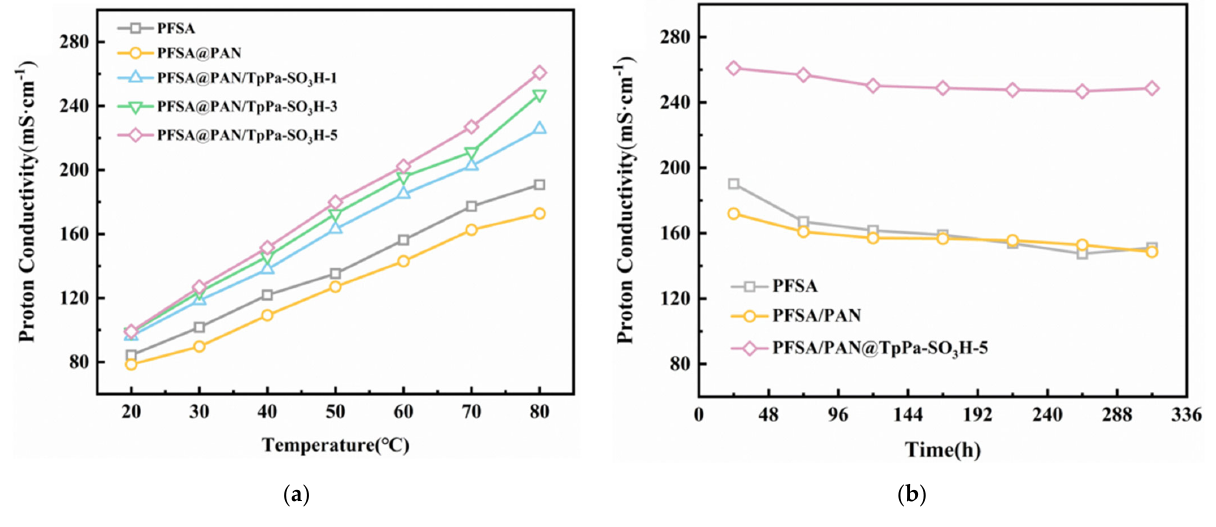
Figure 7. ( a ) Proton conductivities of membranes at 100% RH from 20 °C to 80 °C; and ( b ) proton conductivity stability of membranes at 100% RH and 80 °C.